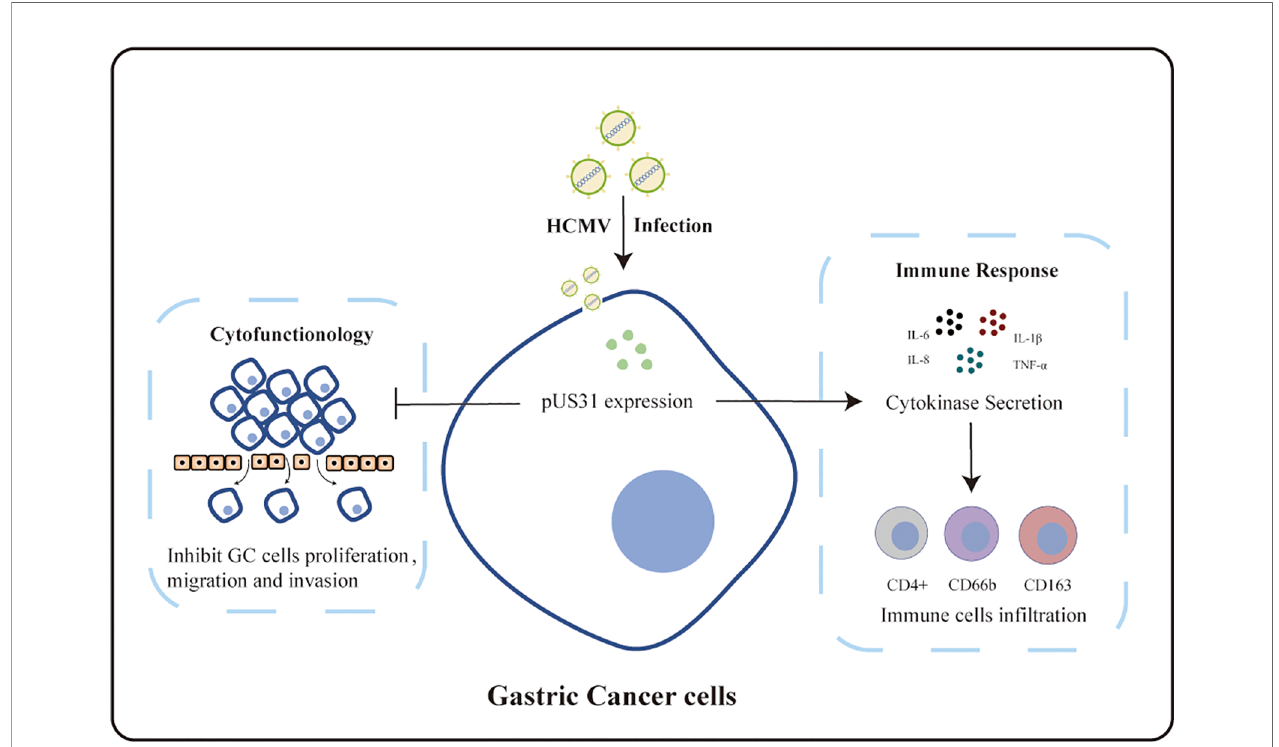
FIGURE 5 | Proposed model for the function landscape of the HCMV-induced US31 expression in